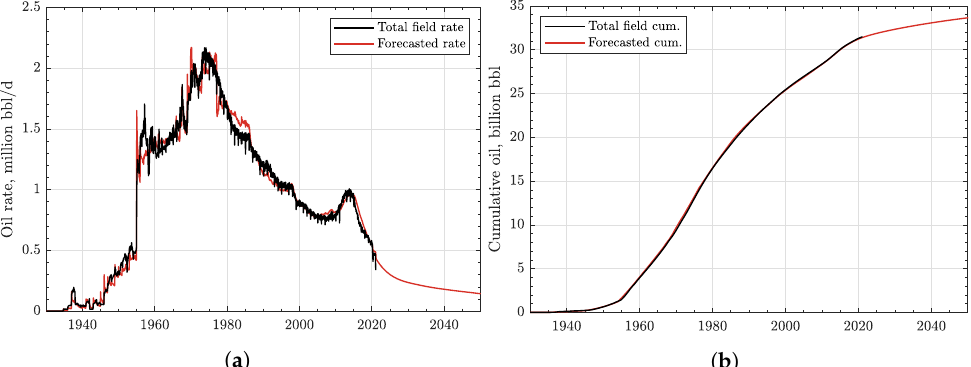
Figure 11. ( a ) Total field rate, ( b ) Total field cumulative forecasts from existing 484,759 wells in the Permian